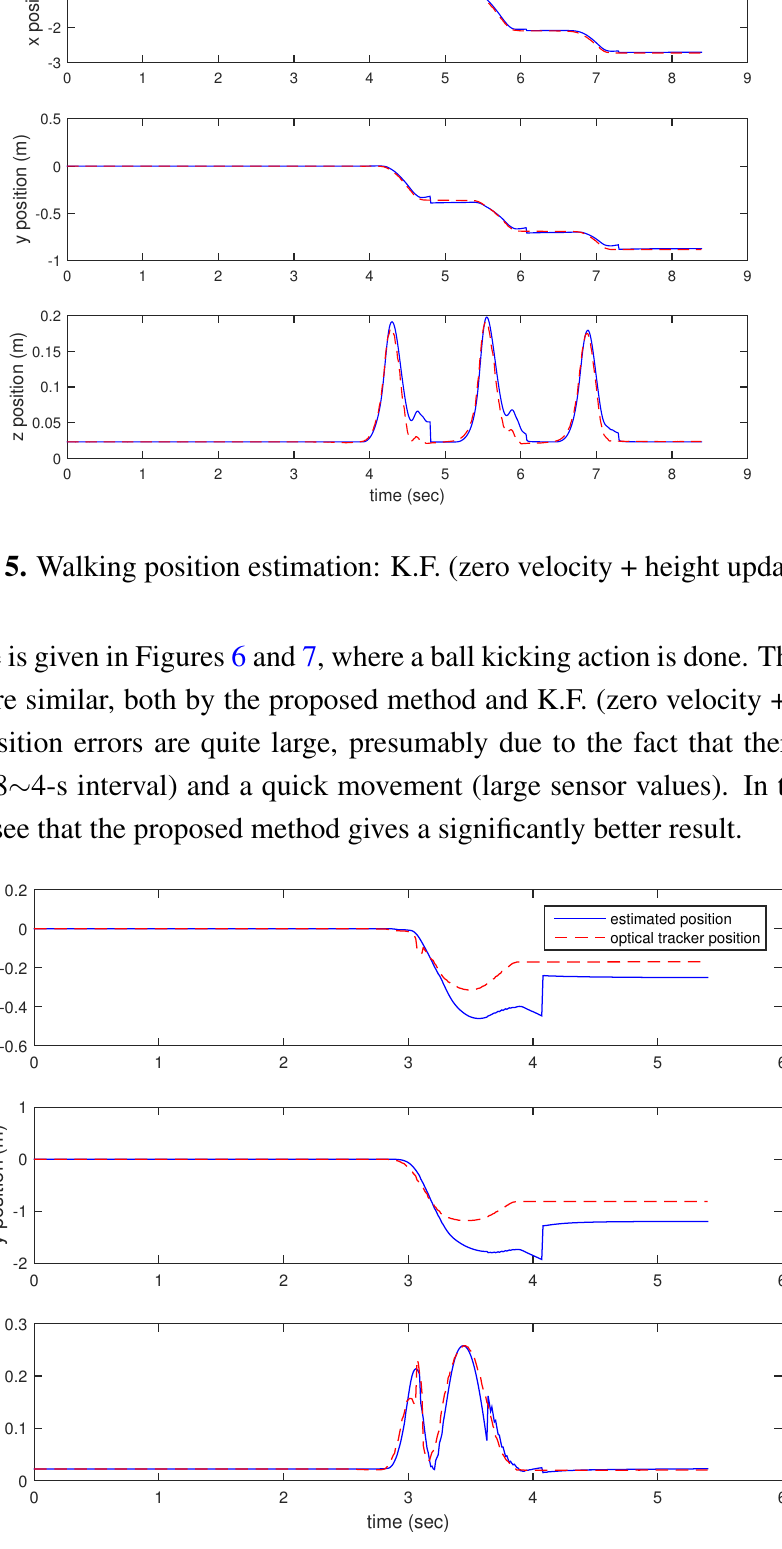
Figure 6. Ball kicking estimation: proposed